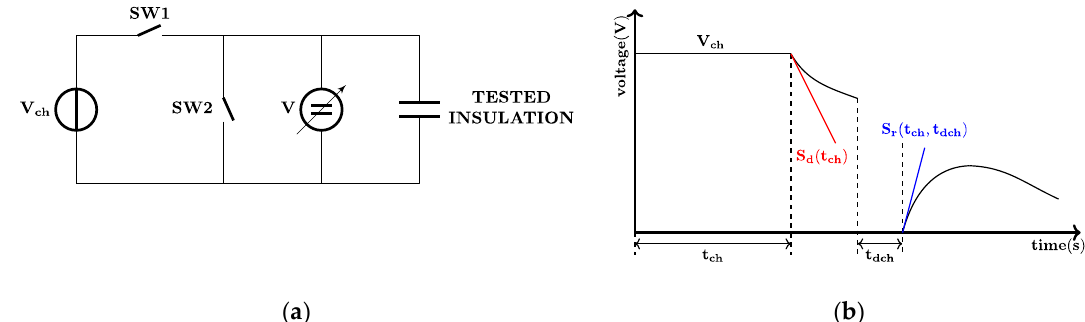
Figure 4. The voltage response measurement: ( a ) Schematic of the measurement. SW1 is used for charging, while SW2 is for discharging. During the measurement, both switches are in OFF position. ( b ) The timing diagram. Charging and discharging times are denoted by t ch and t dch , respectively. S d ( t ch ) and S r ( t ch , t dch ) are the slopes of decay and return voltages, respectively.